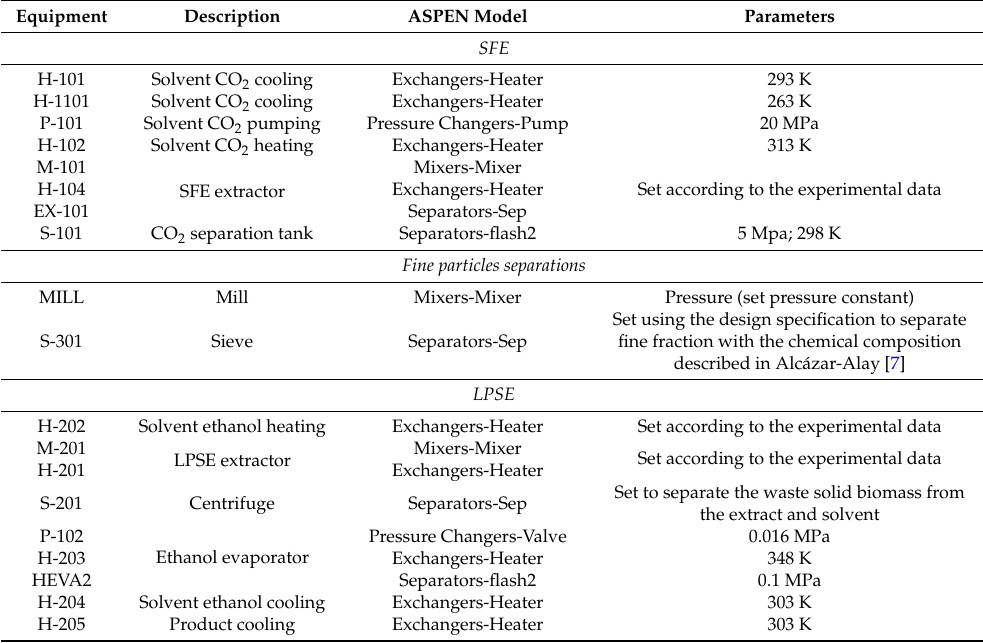
Table A1. Equipment specification simulated in Aspen Plus ® .